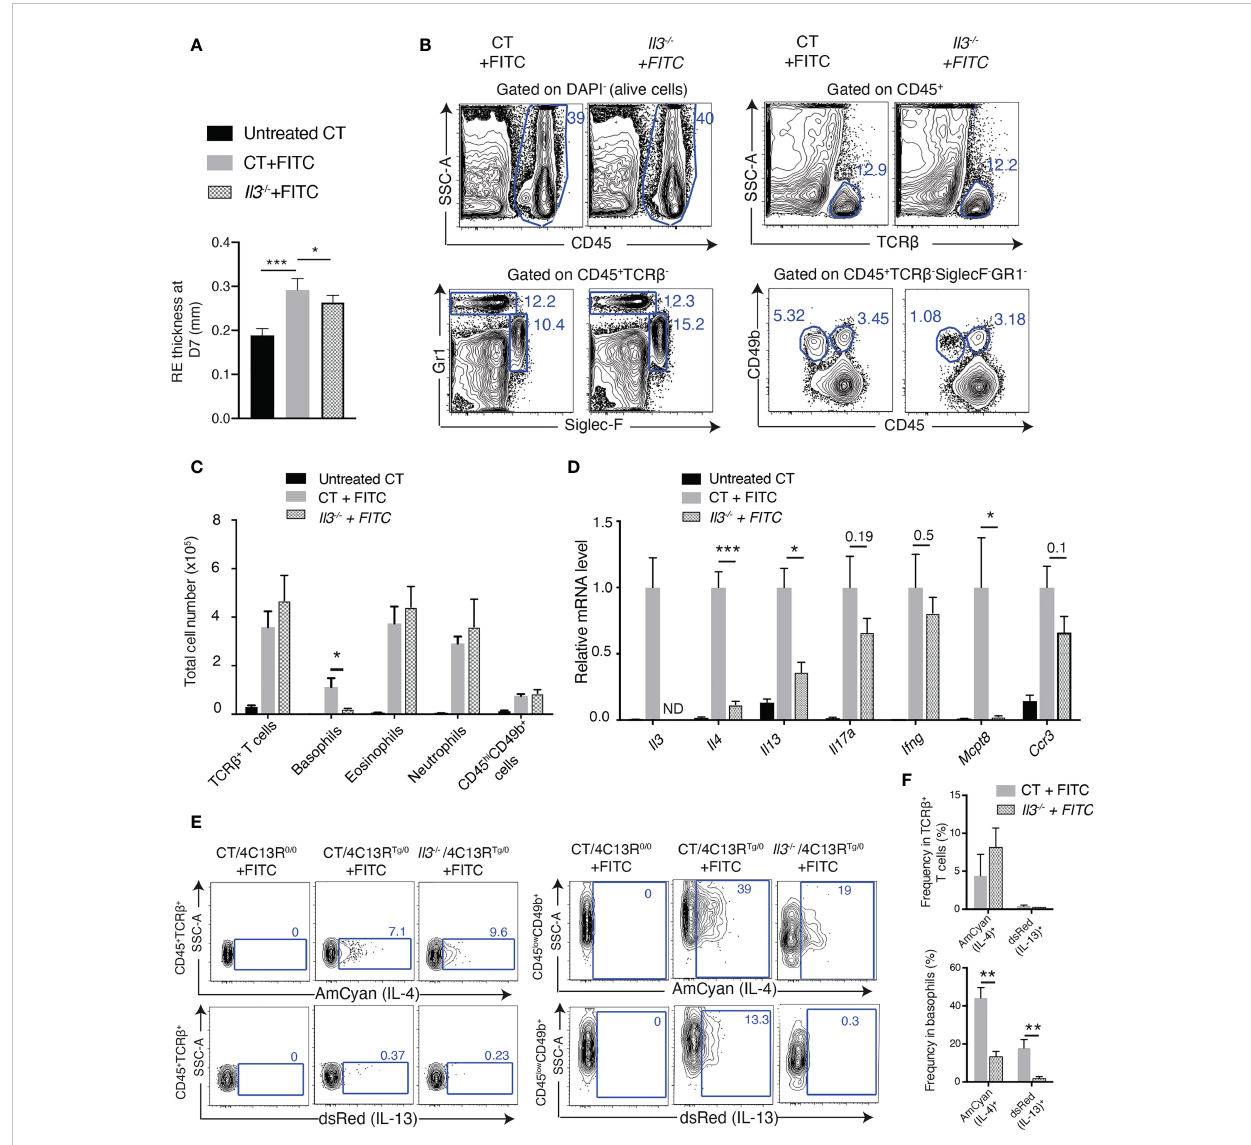
FIGURE 2 IL-3 plays a crucial role for basophil recruitment to FITC-induced ACD skin. (A) Thick- ness of FITC-challenged right ear (RE) at D7. (B) FACS analyses of dermal cells of RES from FITC-treated 113 and wildtype control (CT) littermate mice, for CD45 + hematopoietic cells, CD45 + TCR b + T cells, CD45 + TCR b - Siglec-F + Gr1 low-neg (eosinophils), and CD45 + TCR b - Gr1 hi (neutrophils), CD45 low CD49b + TCR b - Siglec-F - Gr1 - (baso- phils) and CD45 hi CD49b + TCR b - Siglec-F - Gr1 - cells (which contain mast cells),. (C) Comparison of total cell numbers in RE. (D) RT-qPCR analyses of REs.